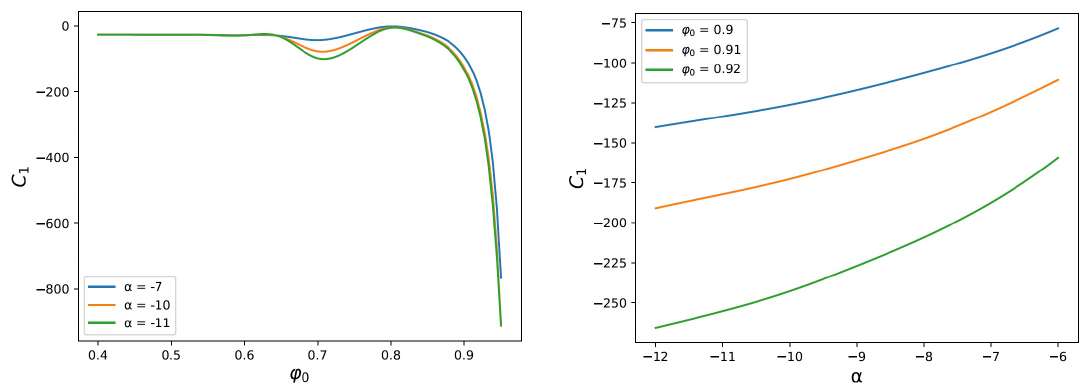
Figure 23 . Left: the integration constant C 1 as a function of ϕ 0 for certain values of α , for Bolt end-point solutions. Right: the integration constant C Bolt end-point